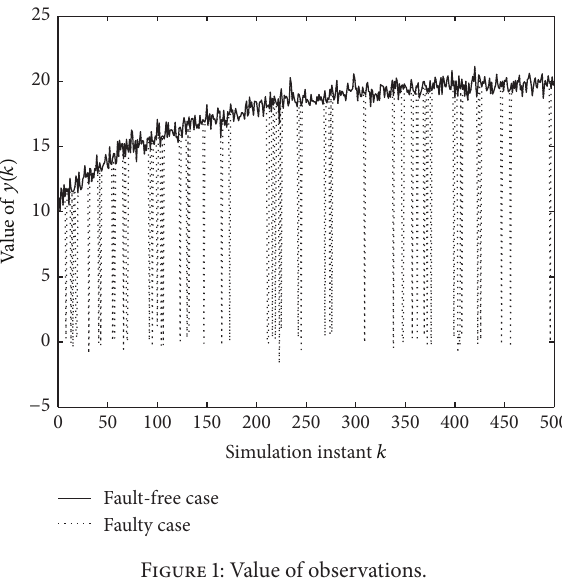
Figure 1: Value of observations.